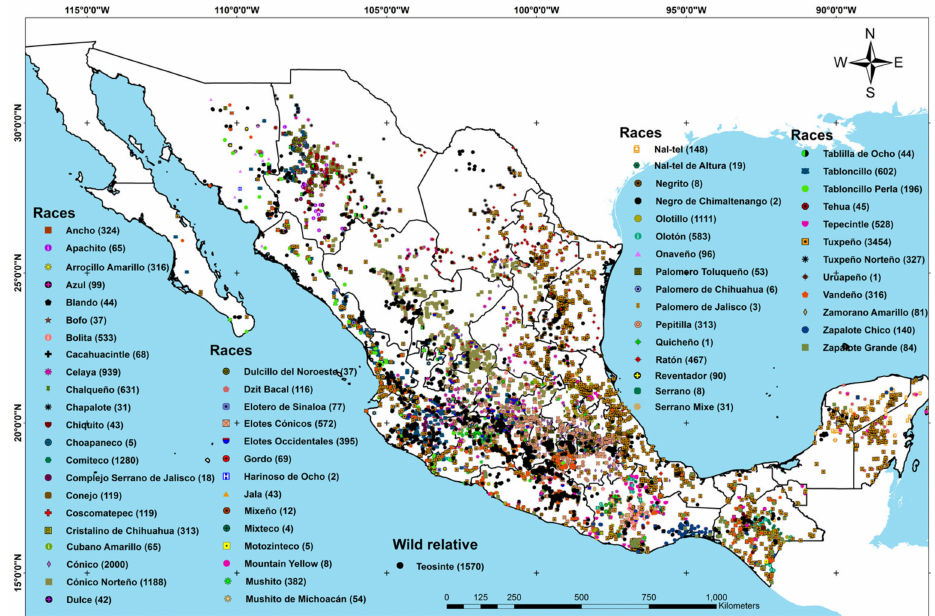
Figure 1. Spatial distribution of maize races in Mexico and their wild relative teosinte. The number of records per race is shown in